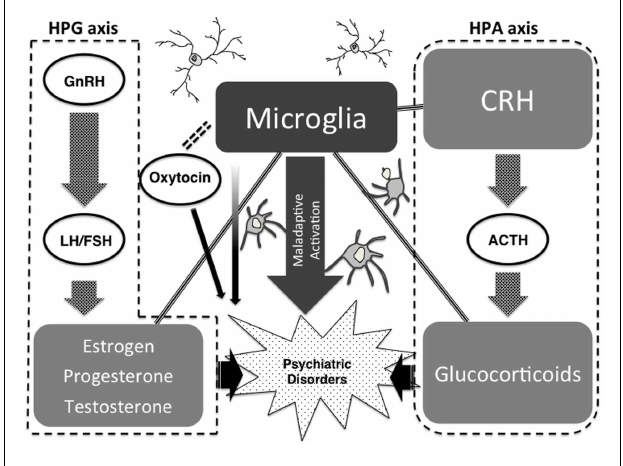
FIGURE 3 | Possible link between neuroendocrine factors, neuropsychiatric disorders, and microglia